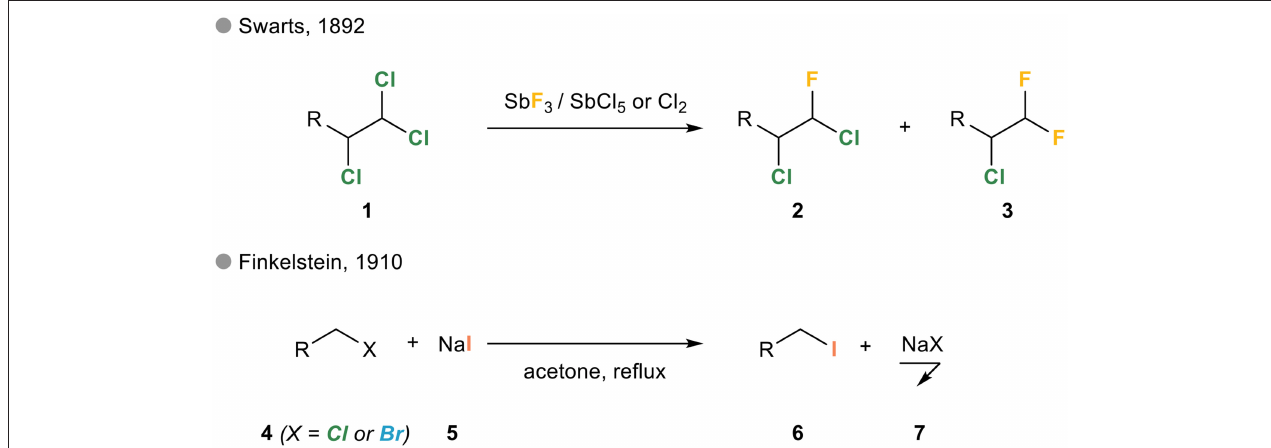
FIGURE 1 | Halogen exchange in alkyl halides: the Swarts and Finkelstein